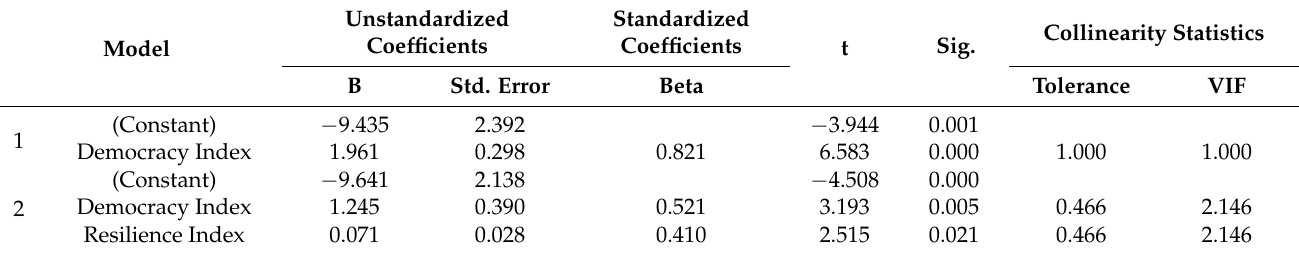
Table 4. Multiple linear equation of regression: predictors for quality of life 1